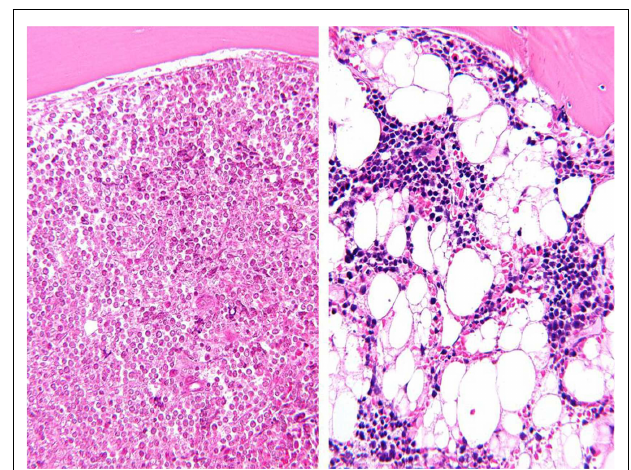
FIGURE 1 | Representative bone marrow biopsies from a patient with childhoodALL before (left) and after (right) induction chemotherapy . Picture taken by Hiro Shimada (Wright-Giemsa stain, magnified 200 ×